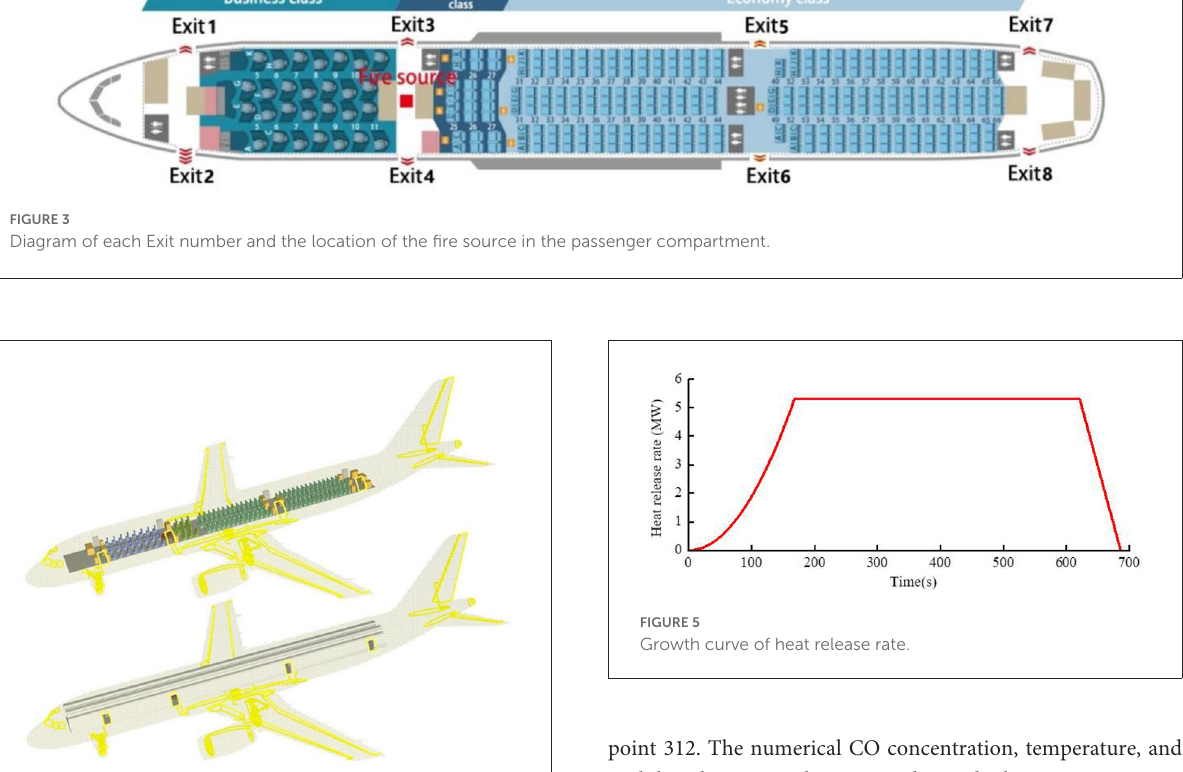
FIGURE4 3D view of the PyroSim model of the Airbus A350-900 aircraft and cabin.